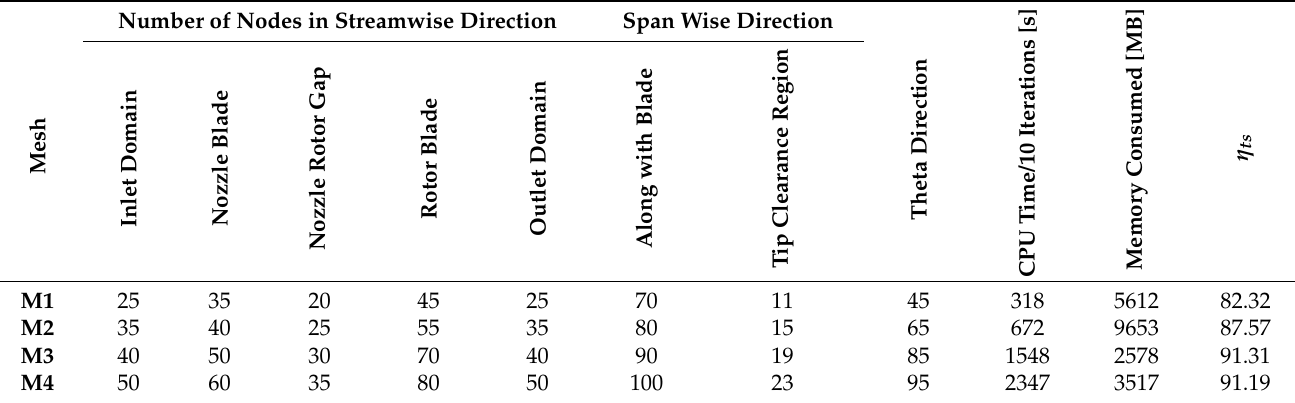
Table 2. Mesh optimization